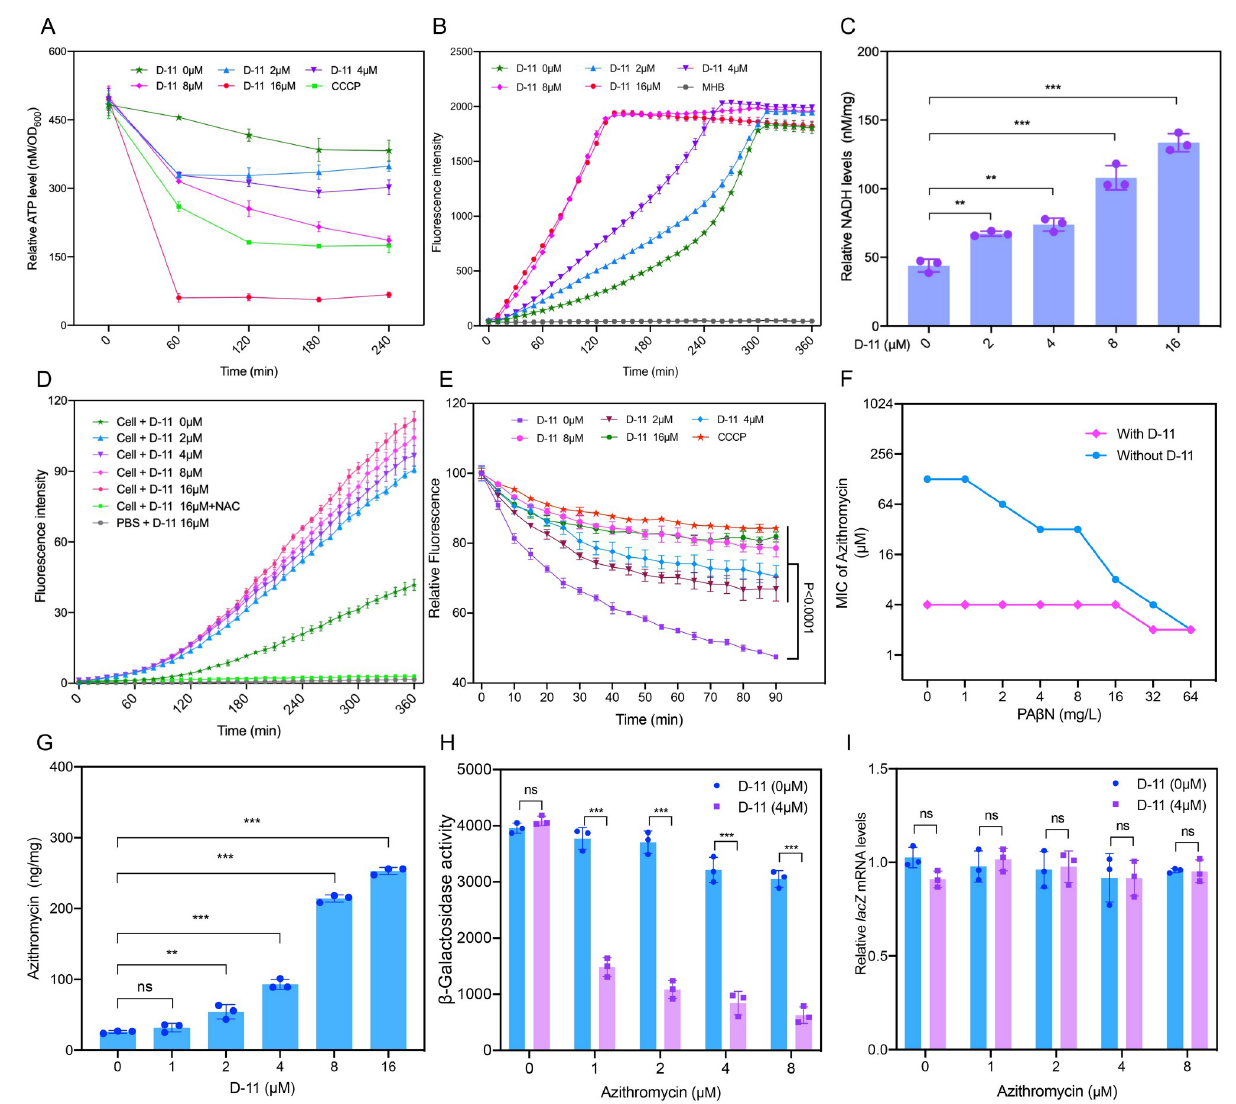
Fig 3. D-11 impairs ATP and NADH levels, induces the accumulation of ROS, inhibits efflux pumps and promotes intracellular antibiotic accumulation. ( A ) Intracellular ATP levels at different D-11 concentrations. 40 mg/L CCCP was used as a positive control. ( B ) Resazurin to resorufin reduction by NADH at different D-11 doses. ( C ) Intracellular NADH concentration after different D-11 doses. ( D ) Total ROS accumulation in PAO1 treated with D-11. Exogenous addition of NAC (6 mM) diminished the accumulation of ROS induced by 16 μ M of D-11. ( E ) D-11 dosage-related EtBr efflux inhibition. PAO1 cells were incubated with EtBr in HEPES for 30 min at 37 ˚C then the cells were collected and resuspended in MHB medium containing the indicated concentrations of D-11 or 40mg/L CCCP. Then the fluorescence was monitored for 90 min at 37˚C. ( F ) D-11 antagonizes the effect of the efflux pumps inhibitor PA β N. ( G ) Intracellular D-11 dosage-related increment of azithromycin. ( H ) β -Galactosidase activity for the combination of azithromycin and D-11. ( I ) Relative lacZ mRNA expression levels for D-11 and D-11/azithromycin-treated cells. All the tests were performed in triplicate and all the data are presented as mean ± SD. � , P < 0.05; �� , P < 0.01; ��� , P < 0.001; ns, not significant by Student’s t-test.